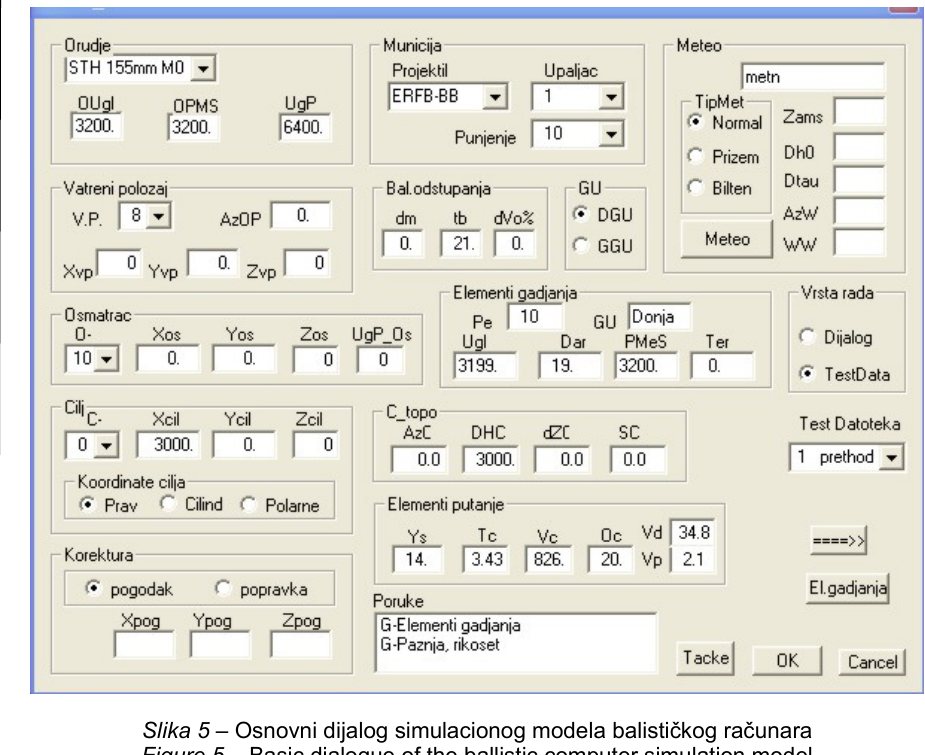
vima programa za izradu tablica ga đ